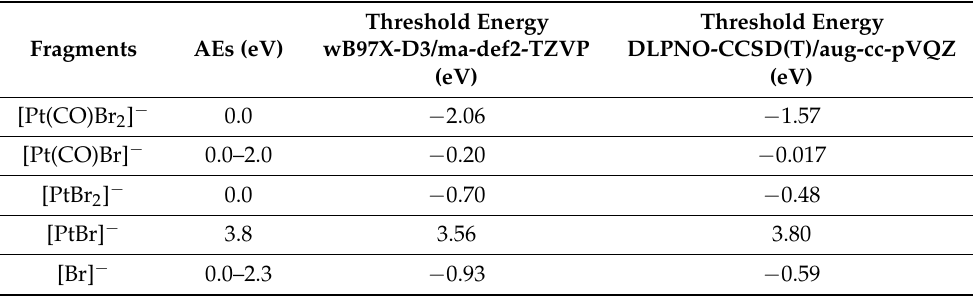
Figure 5. Negative ion yields for [Pt(CO)Br] − , [PtBr] − and Br − . Table 2. Appearance energies and calculated thermochemical thresholds for all observed DEA fragments calculated at the wB97X-D3/ma-def2-TZVP and DLPNO-CCSD(T)/aug-cc-pVQZ level of theory. Threshold energies include the thermal energy of the neutral at 50 °C.